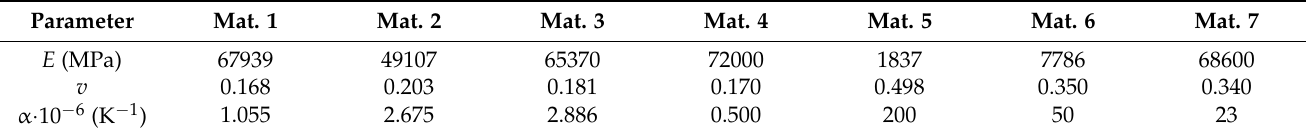
Table 2. Thermo-mechanical properties of the